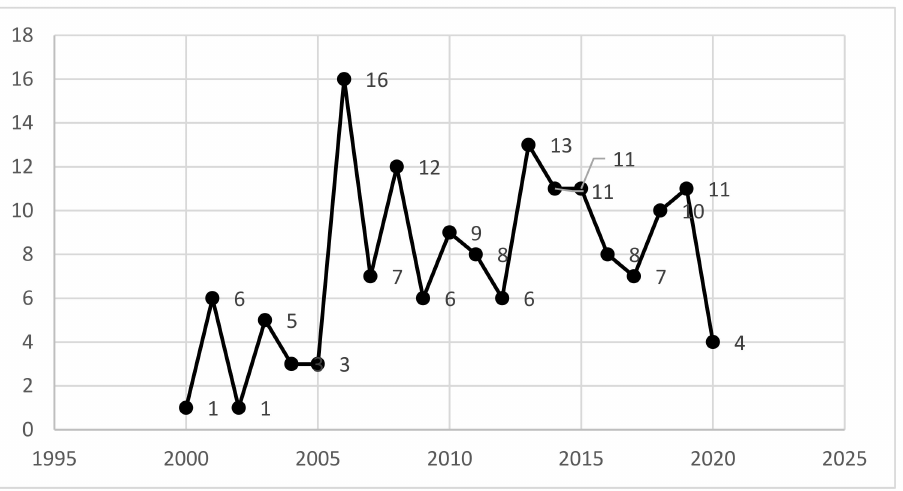
Figure 2. Results of searching in SCOPUS by year of document ( n = 158). Source: Own